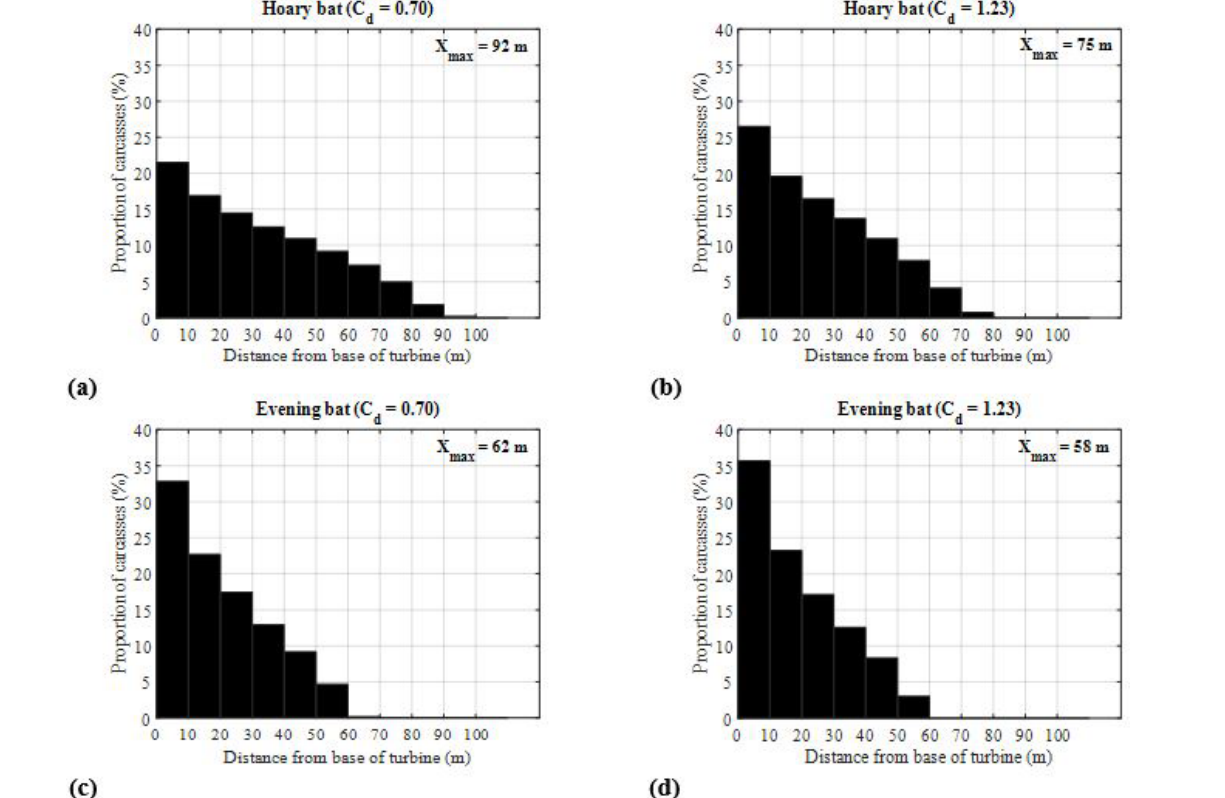
Figure 9. Carcass fall distributions for (a) the hoary bat ( C d = 0 . 70), (b) the hoary bat ( C d = 1 . 23), (c) the evening bat ( C d = 0 . 70), and (d) the evening bat ( C d = 1 .